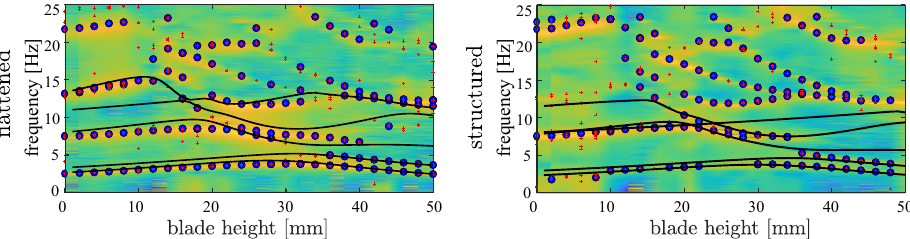
Figure 14. The natural frequencies of the FE model with the artificial elastic layer (black lines) and the measured averaged Frequency Response Function in the function of the blade height presented as a waterfall diagram. The colour scale denotes the logarithmic amplitude of the averaged FRF, the red crosses denote all the fitted natural frequencies by means of the ISD method for each excitation and the blue circles denote the consistent fitted natural